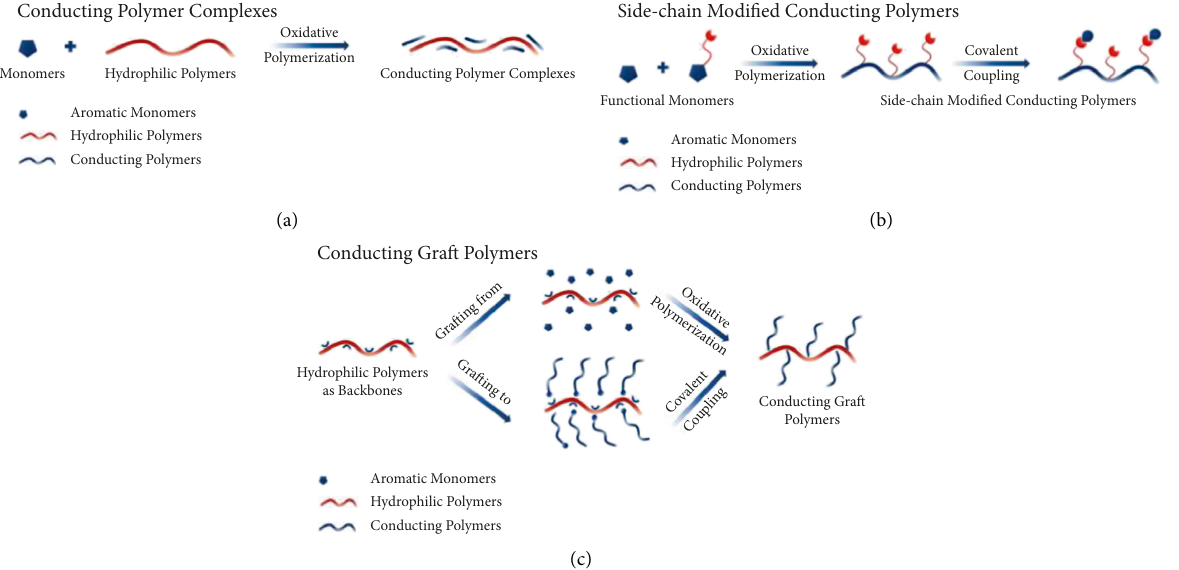
Figure 1: Schematic diagram of preparing functional CP. (a) CP compound, (b) Side chain modification CP, and (c) Electroconductive graft polymer [34]. Copyright 2021, with permission from Elsevier. Table 1: Uses of conducting polymer-based hydrogels in heart repair and regeneration.